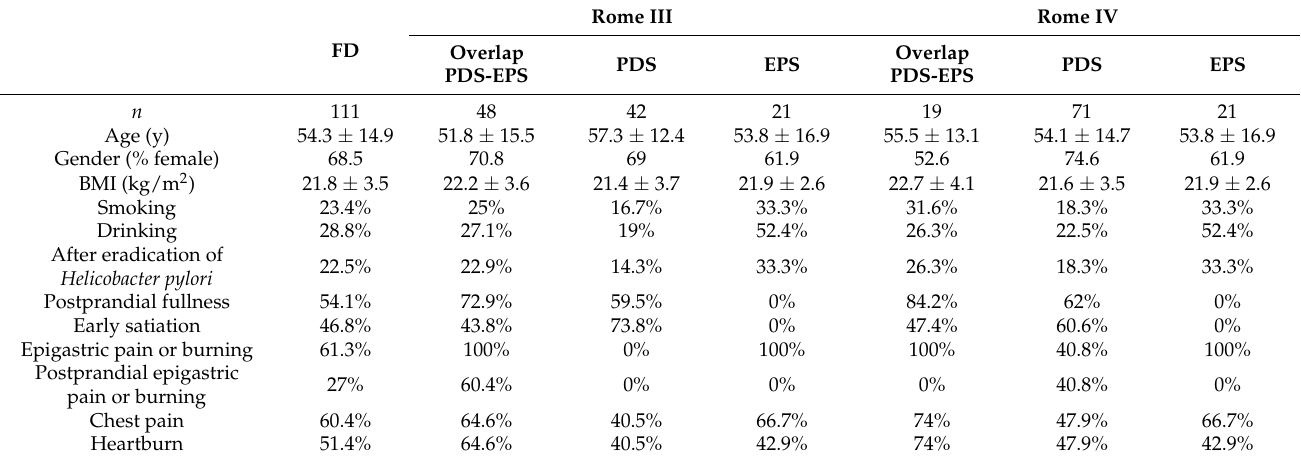
Figure 1. CONSORT chart. Figure 1 . CONSORT chart. Table 1. Characteristics and symptoms of the Table 1. Characteristics and symptoms of the patients.